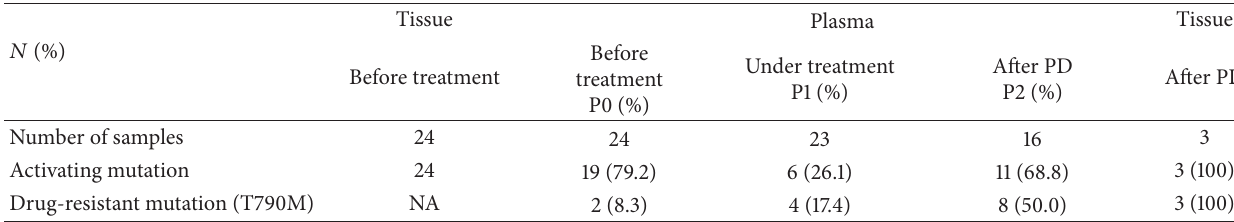
Table 3: Detection of EGFR mutations from tissue and plasma samples.